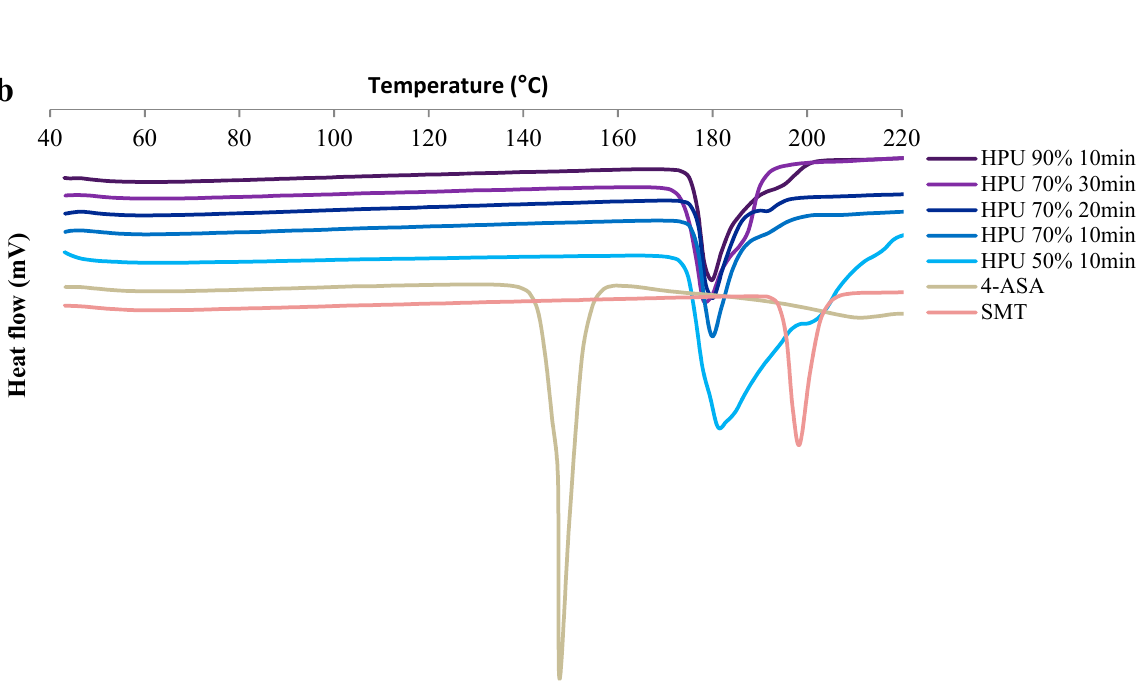
Figure 4. Differential scanning calorimetry (DSC) thermograms of the cocrystals. ( a ) Cocrystals prepared by HPH and ( b ) cocrystals prepared by HPU. HPH: high pressure-homogenization; HPU: high-power ultrasound; c: number of HPH cycles; percentage refers to HPU amplitude.